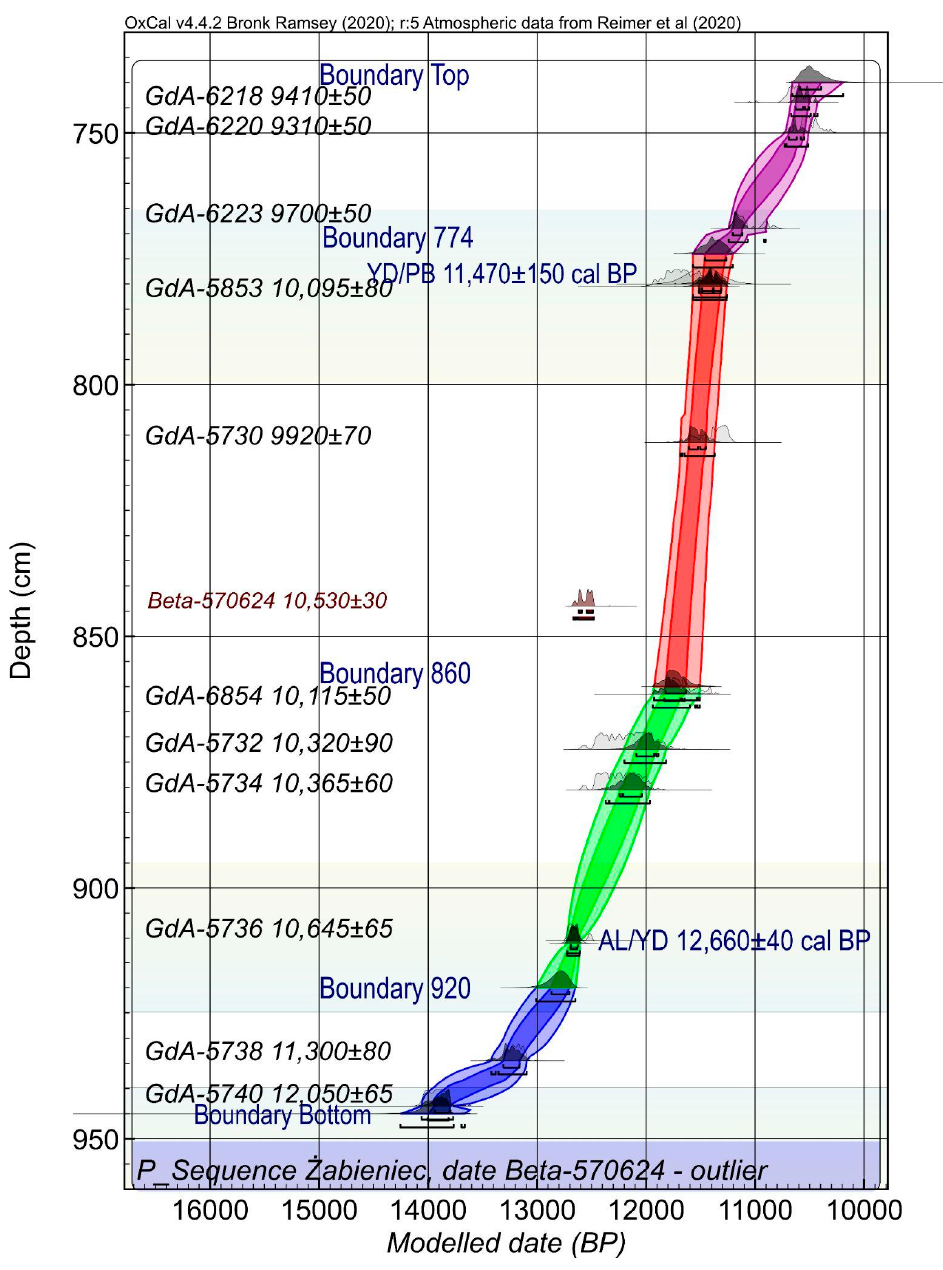
Figure 2. Age–depth model established for sediment sequence of Ż abieniec mire (followed Petera ‐ Zganiacz et al. [32]). Light blue boxes mark the studied sediment sections.